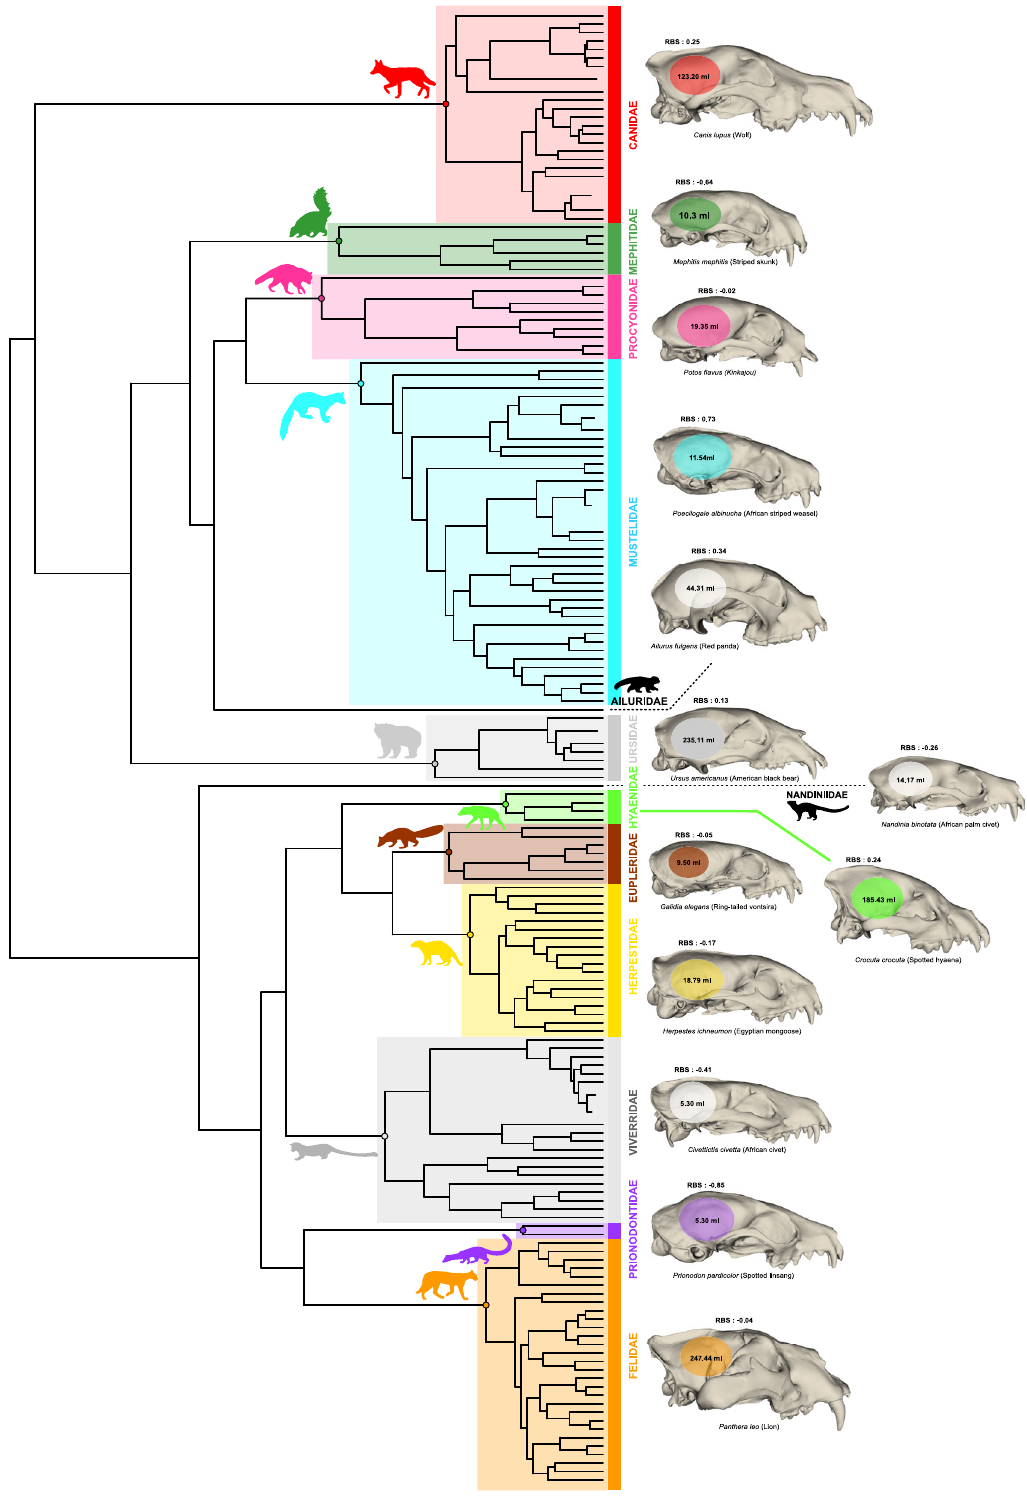
Fig. 2 Phylogeny of the Carnivora order and illustrations of representative species. The phylogenetic relationships of the carnivoran species used in this study, derived from Slater and Friscia (2019) associated with illustrations of a representative species of each family, its estimated brain volume, and the relative brain size (RBS). 3D crania represent different specimens from our dataset. They were digitized using a white light fringe surface scanner and a laser surface scanning. The silhouettes were drawn by the authors (M.M) and are available on the Phylopic website